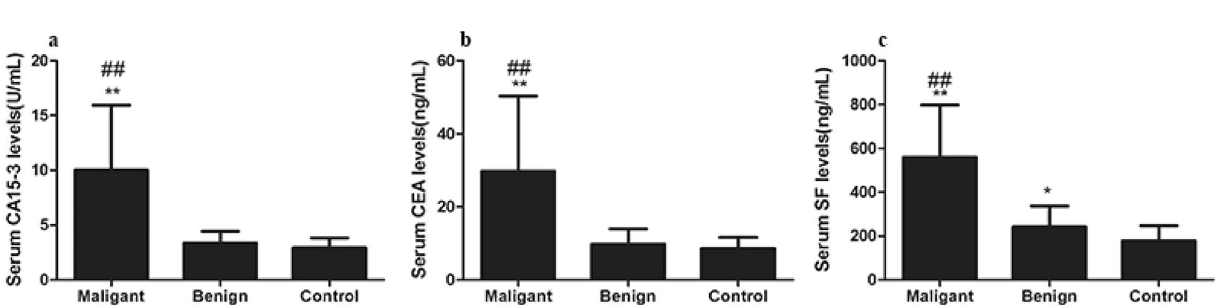
Figure. 2. Expression levels of CA15-3, CEA, and SF in serum of canine mammary tumor. (a) Serum CA15-3 levels of malignant tumor group, benign tumor group, and healthy control group. (b) Serum CEA levels of the three groups. (c) Serum SF levels of the three groups. Note: * P < 0.05 showed significance difference, ** P < 0.01 showed extremely significant difference vs control group; # P < 0.05 showed significance difference, ## P < 0.01 showed extremely significant difference vs benign mammary gland tumor